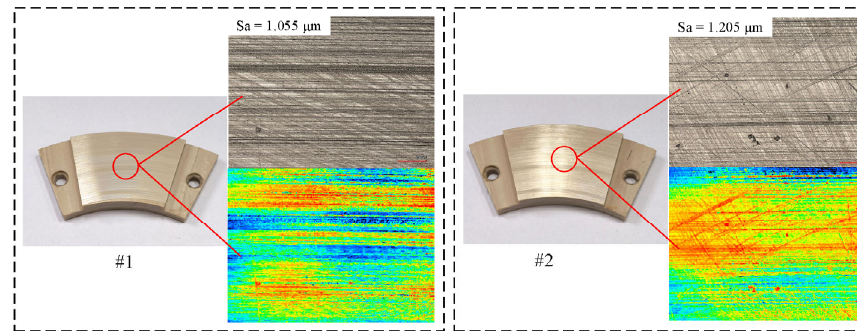
Fig. 23 Surface morphology of the bearings after wear.